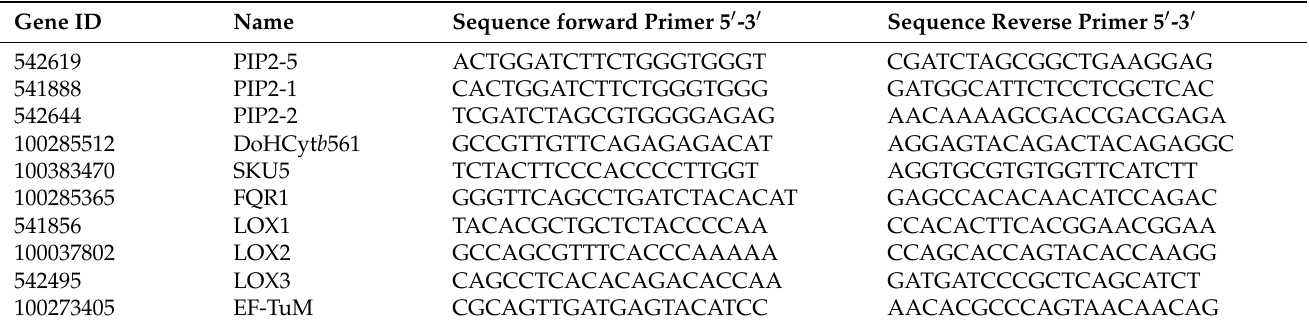
Table 1. Primer sequences in 5 (cid:48) -3 (cid:48) -orientation for